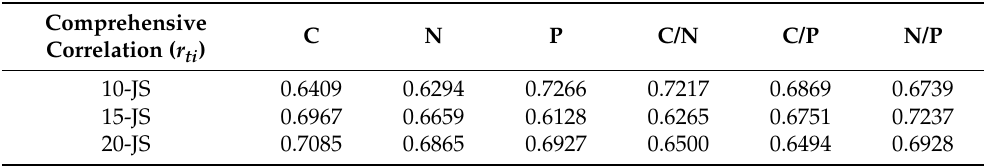
Table 4. Comprehensive correlation between soil factors and Indigofera Amblyantha Craib factors under different precipitation